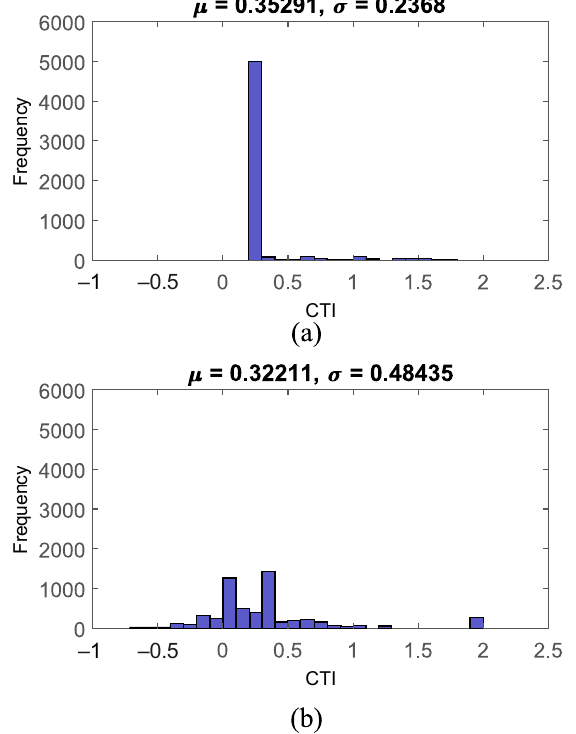
Figure 6. Frequency distribution of CTIs obtained by ( a ) the APS and ( b ) the PSFOS.